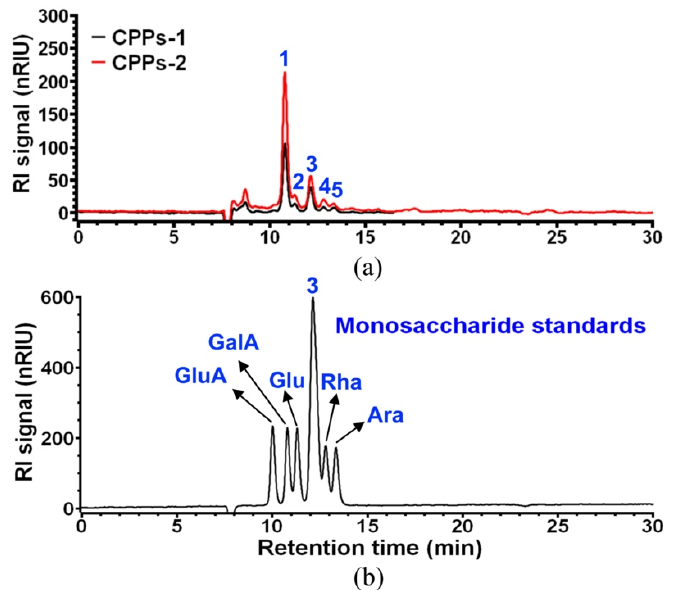
Figure 11. HPLC analysis of constituent monosaccharides of CPPs ‐ 1 and CPPs ‐ 2 ( a ) and monosaccharide standards ( b ). The peaks 1, 2, 4 and 5 in ( a ) are identified as GalA, Glu, Rha and Ara, respectively. Peak 3 in ( a ) cannot be identified, because its corresponding standard peak (blue peak 3 in ( b )) represents the peak of co ‐ eluted Gal, Xyl, Man and Fuc. Table 6. Monosaccharide composition and their molar ratio of CPPs ‐ 1 and CPPs ‐ 2. Monosaccharides and Molar Ratios GluA GalA Glu Rha Ara Gal/Xyl/Man/Fuc CPPs ‐ 1 0.04 2.09 0.23 0.27 0.26 CPPs ‐ 2 nc